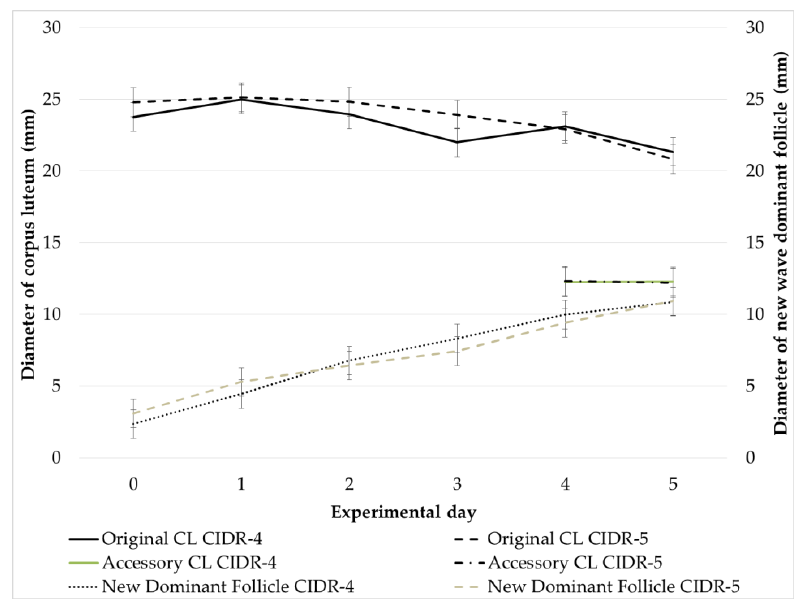
Figure 2. Development of original CL, accessory CL and new wave dominant follicle during experimental period.